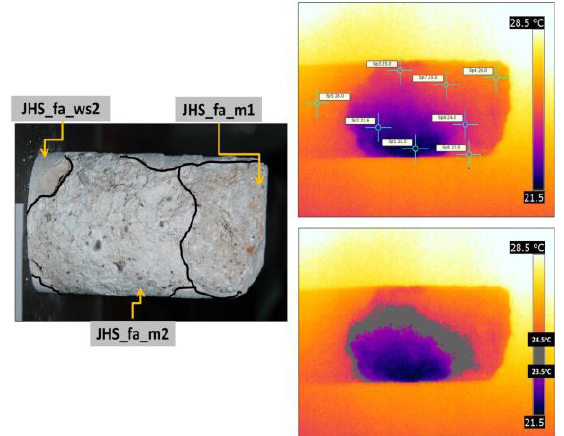
Figure 12: Assessment of physicochemical incompatibility between the joint mortars and the stone, as assessed by infrared